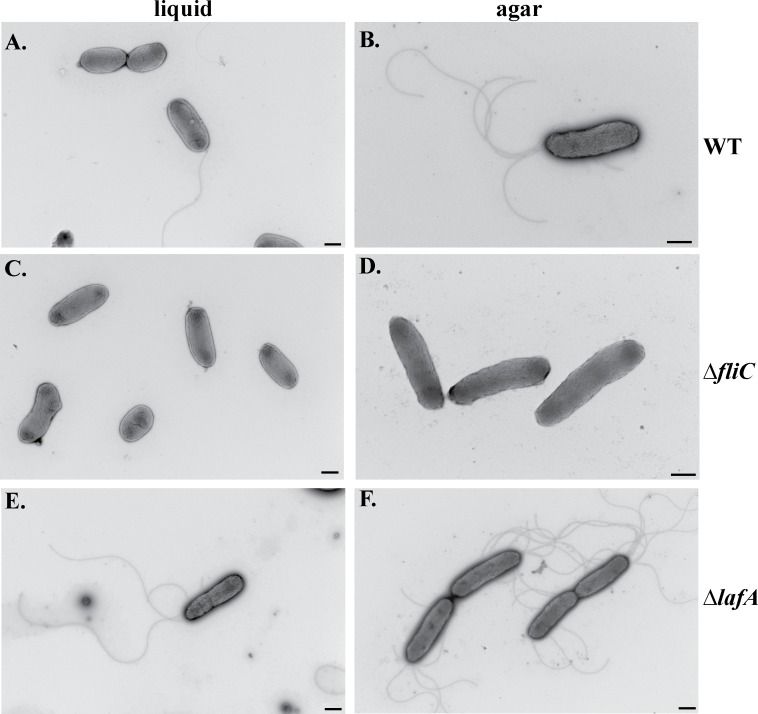
Production of B. dolosa flagella in nutrient-rich media.B. dolosa strains were grown in either LB liquid medium (panels A, C, and E) or grown on TSA plates (panels B, D, F) then subjected to transmission electron microscopy. Representative images are shown for B. dolosa wild-type (panels A and B), B. dolosa ΔfliC (panels C and D), or B. dolosa ΔlafA (panels E and F). Black bars indicate 500 nm scale. Representative images of 10 replicate images are shown.